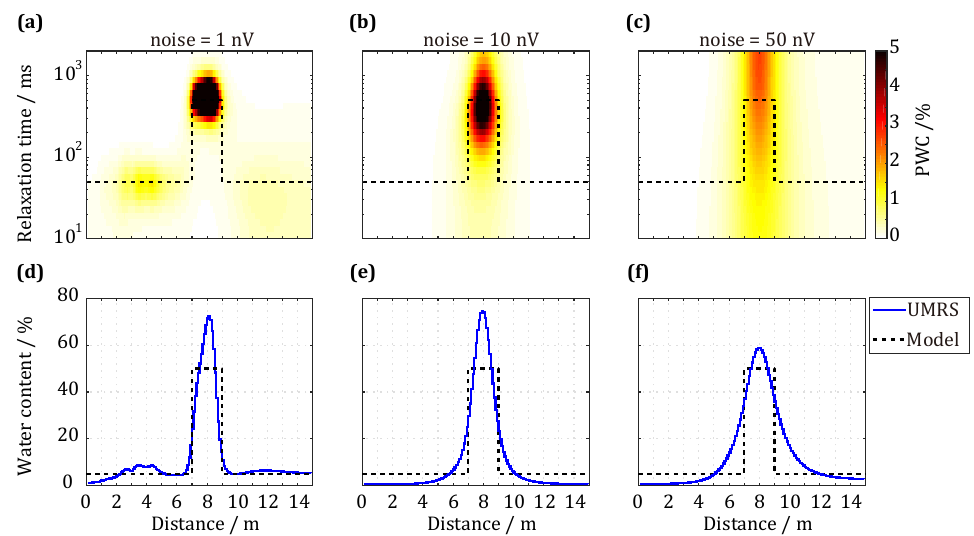
Figure 3. Inversion results of a single water-bearing layer model with a center location of 8 m in front, a water content of 50% and a relaxation time T ∗ of 500 ms. ( a – c ) The distribution of inverted partial 2 water content (PWCs); and ( d – f ) the total water content distribution for the noise level 1 nV, 10 nV and 50 nV,